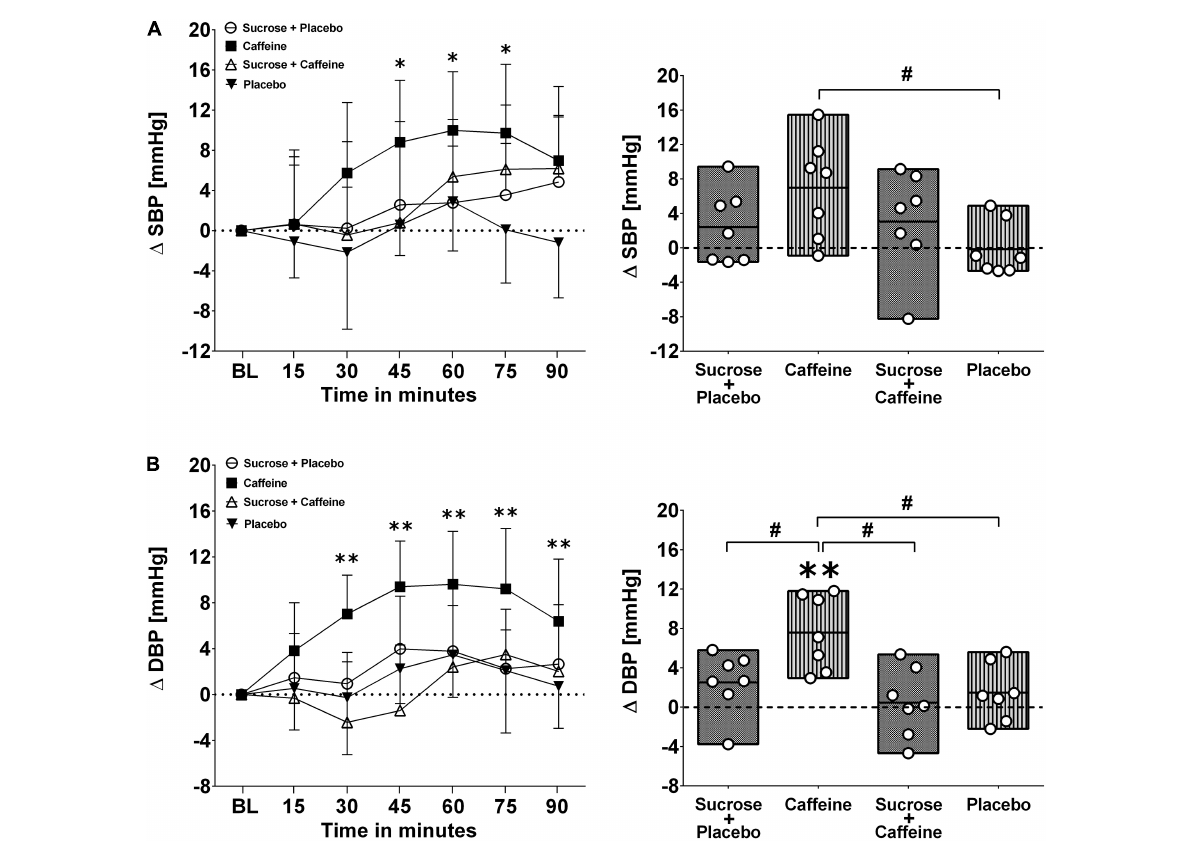
FIGURE1 Left panels (A,B) : Time course for changes in systolic blood pressure (stocktickerSBP) and diastolic blood pressure (DBP) in response to the four drinks. Each mean value (i.e., 15-min blocks) corresponds to the average over the respective interval that was subtracted by its baseline (BL) values. Data are presented as means ± standard deviation. Right panels (A,B) : Boxes (minimum to maximum values) represent individual mean responses (open circles) averaged over 90 min post-drink and subtracted by baseline values for each drink, respectively. In both panels, asterisks show statistically significant differences over time from baseline values (both panels) at ∗ p < 0.05 and ∗∗ p < 0.01. For right panels only, # p < 0.05 represents statistically significant differences between responses to the drinks as analyzed by one-way repeated measures analysis of variance with Holm–Sidak’s post hoc